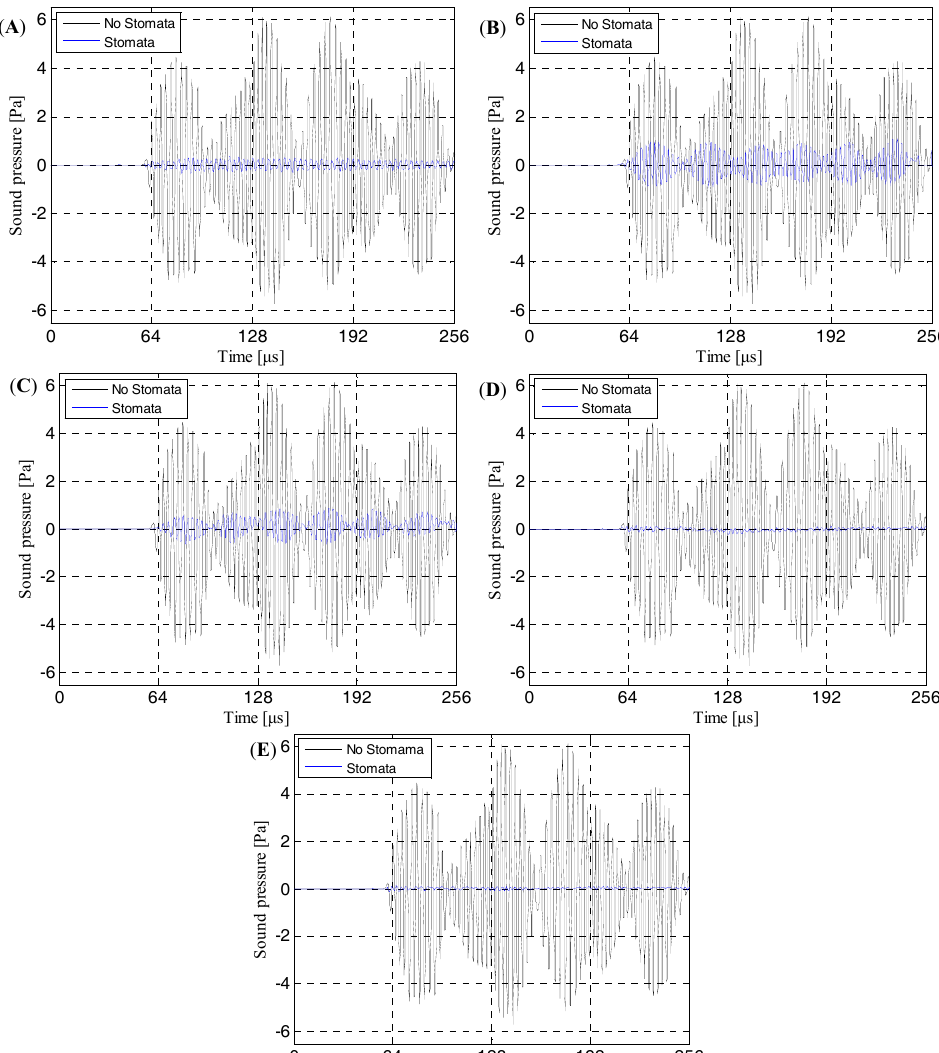
Figure 18. The transmission signals of the intact model and defective model with a stomata defect in the second, third, fourth, fifth and sixth electrolyte layer of the lithium-ion battery. ( A ) The stomata defect in the second electrolyte layer of the lithium-ion battery, ( B ) the stomata defect in the third electrolyte layer of the lithium-ion battery, ( C ) the stomata defect in the fourth electrolyte layer of the lithium-ion battery, ( D ) the stomata defect in the fifth electrolyte layer of the lithium-ion battery and ( E ) the stomata defect in the sixth electrolyte layer of the lithium-ion battery.